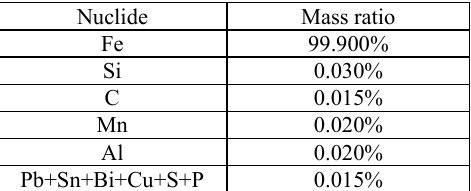
Fig.2 Experimental neutron leakage time spectra measured at 60°.